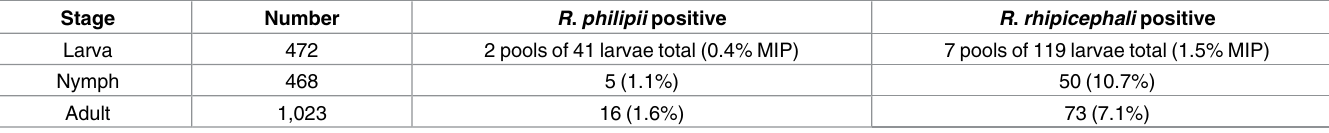
Table 4. Life stages of Dermacentor occidentalis tested for Rickettsia philipii and R . rhipicephali by PCR, Lake, Sonoma, and Mendocino Coun- ties, California, 2008–2014.